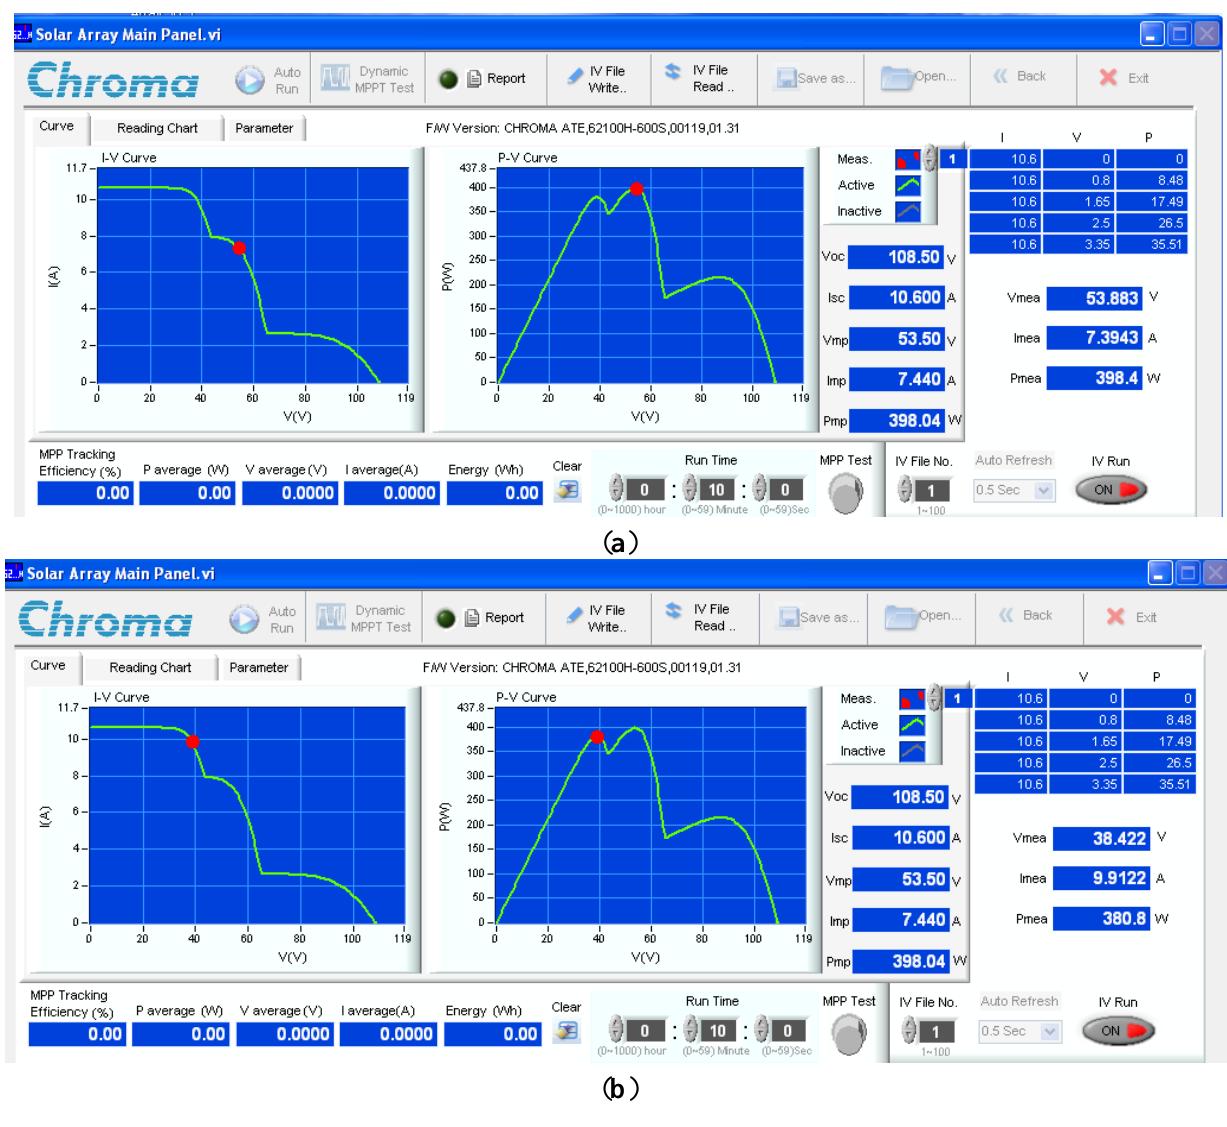
Figure 19. P - V and I - V curves under PSC ( a ) The detected GMPP by S1 and S3 and ( b ) The failed detected GMPP by